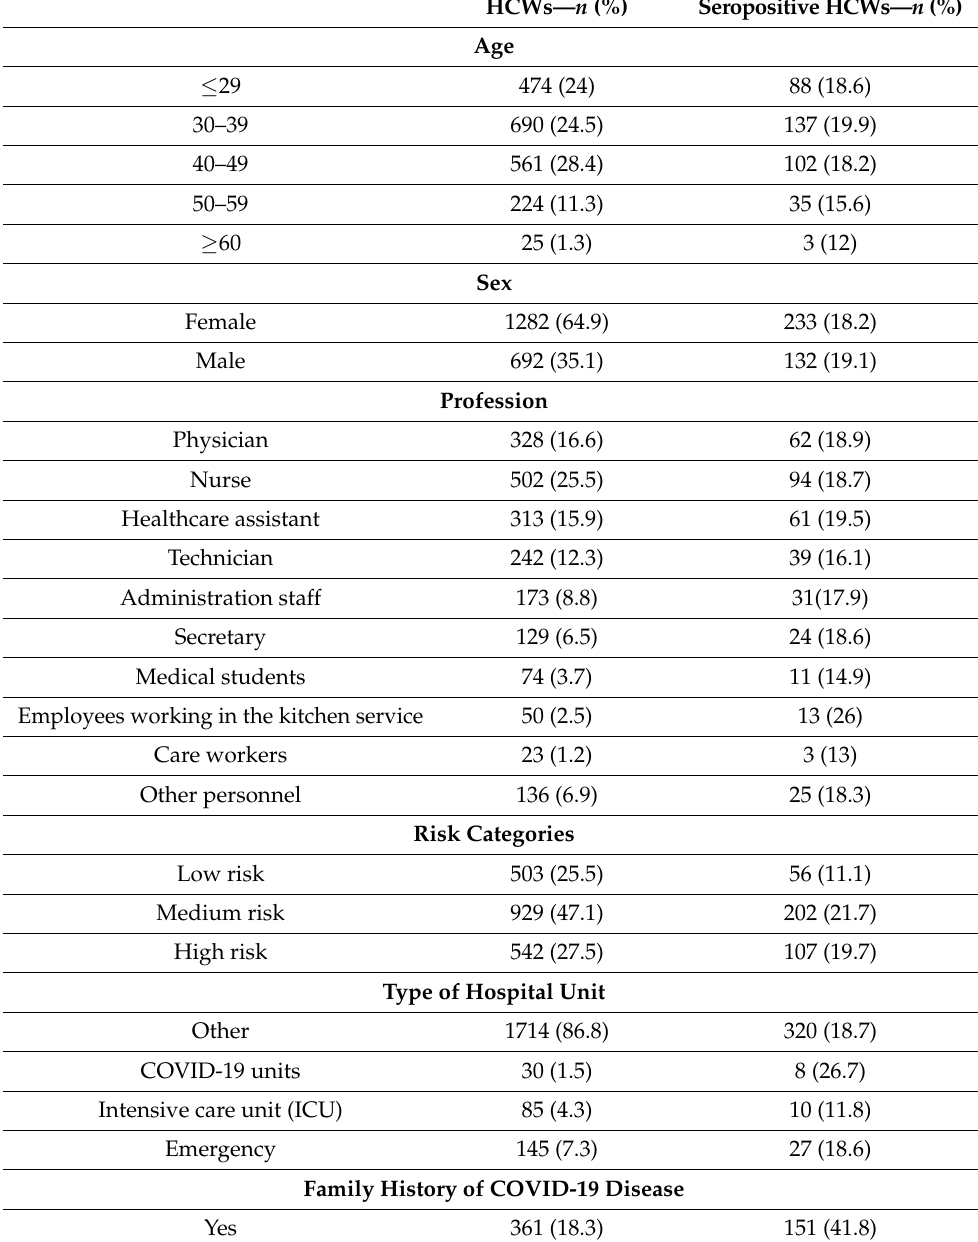
Table 1. Baseline demographic characteristics of healthcare workers